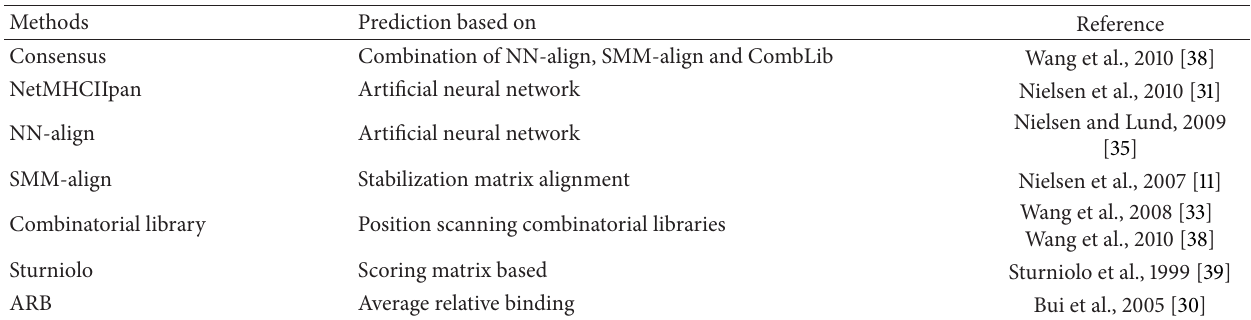
Table 1: The MHC class II prediction tools available at IEDB. A user may choose from one of the seven prediction methods provided. The consensus method is used as the default method and is composed of three of the most successful individual prediction